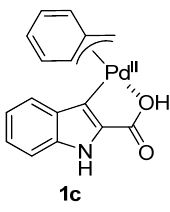
Figure 2. Role of carboxylic acid as a directing